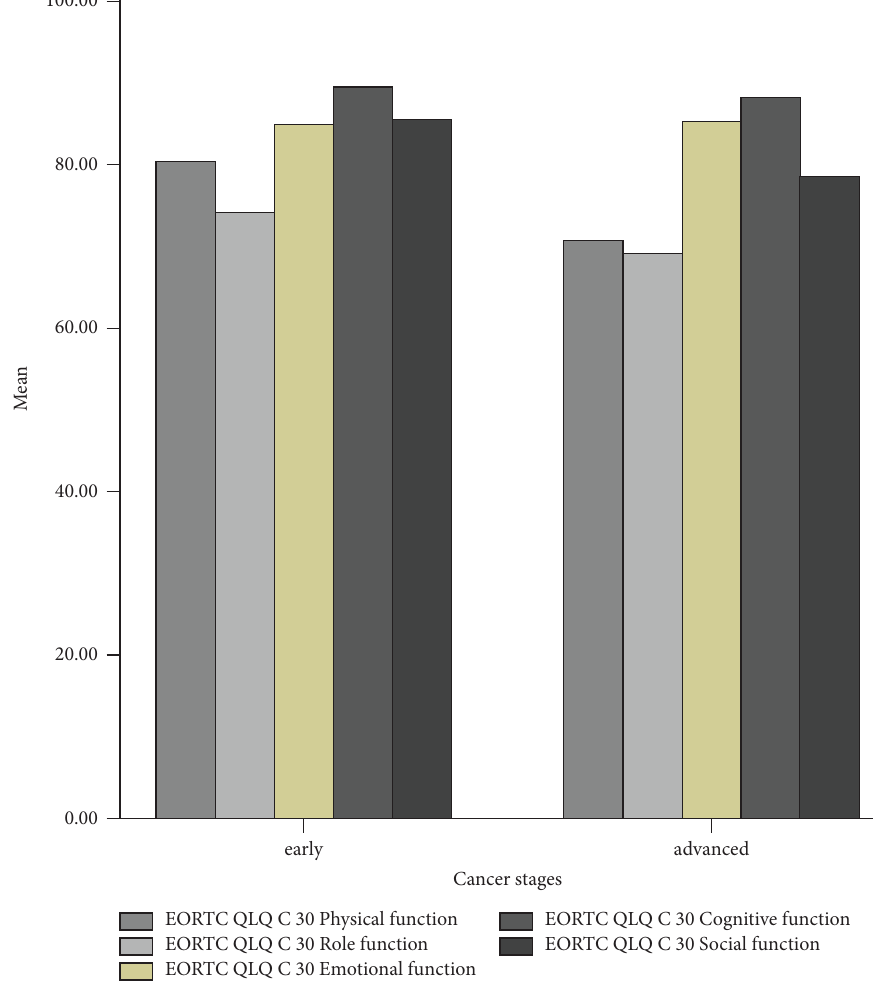
Figure 3: HRQoL domains based on cancer